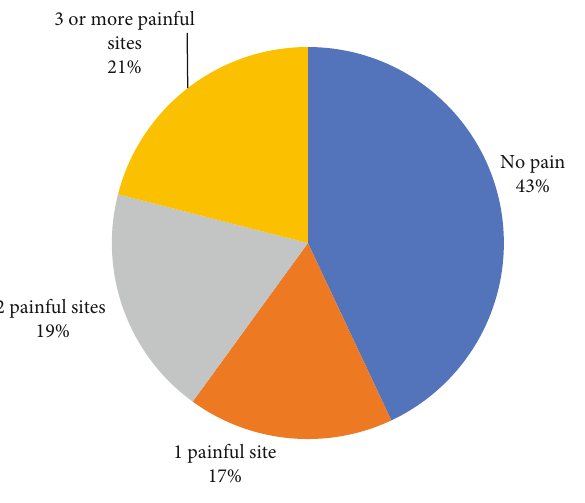
Figure 1: Number of painful sites.